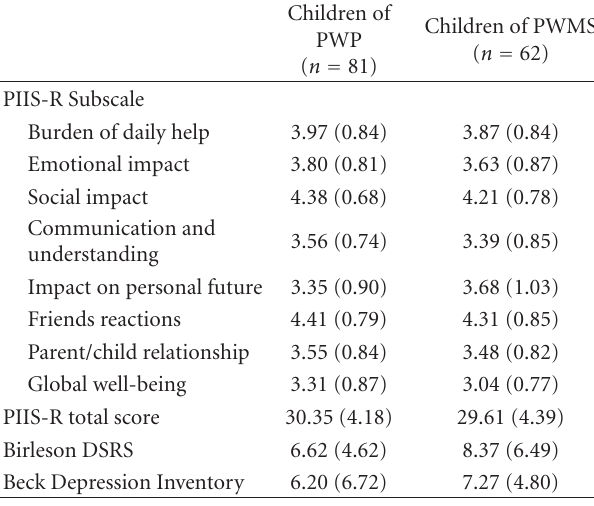
Table 2: Mean values by parental condition for QoL and depres-